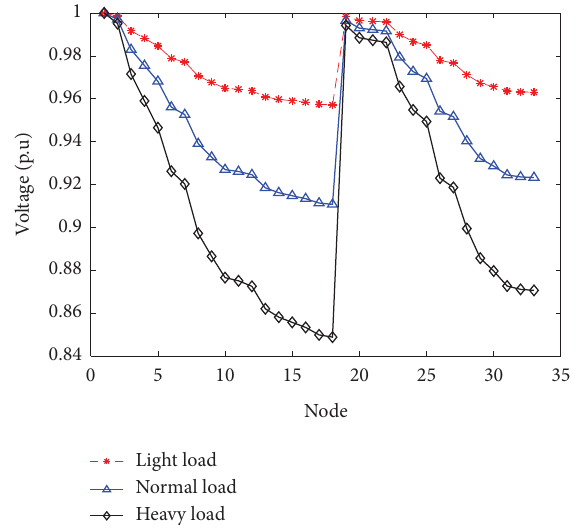
Figure 3: Voltage profle of 33-bus system base case condition at diferent load